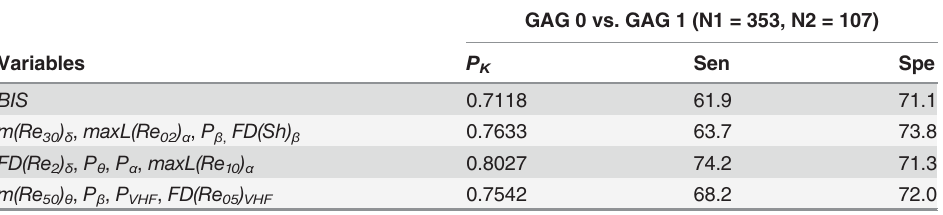
Table 5. GAG assessment: multi-variable discrimination between EEG windows taken 30 s before the tube insertion: absence (GAG = 0) and presence of gag